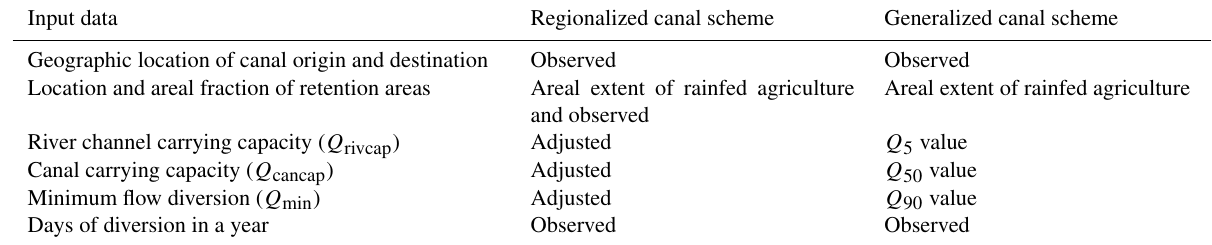
Table 2. The differentiation of regionalized and generalized canal schemes in terms of the input data (JICA, 2013; Tamada et al., 2013).